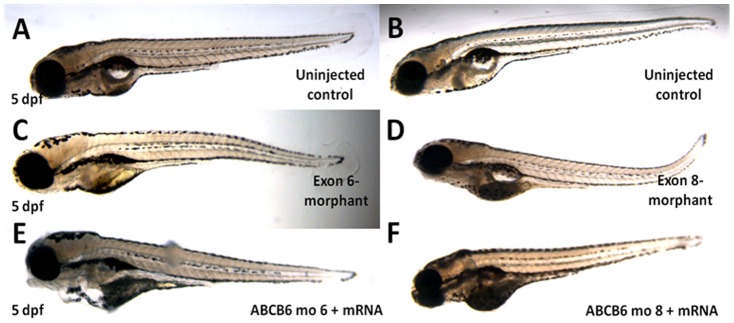
Phenotypes of the microinjected zebrafish.Morpholinos against exon 6 and exon 8 of zABCB6 and wildtype zABCB6 mRNA transcript (in case of rescue) were designed and injected into one- to two-cell stage embryos. No obvious phenotypic changes were observed in the morphants (C and D) and rescued (E and F) embryos after 5 days (5pdf) with reference to their uninjected counterparts (A and B).